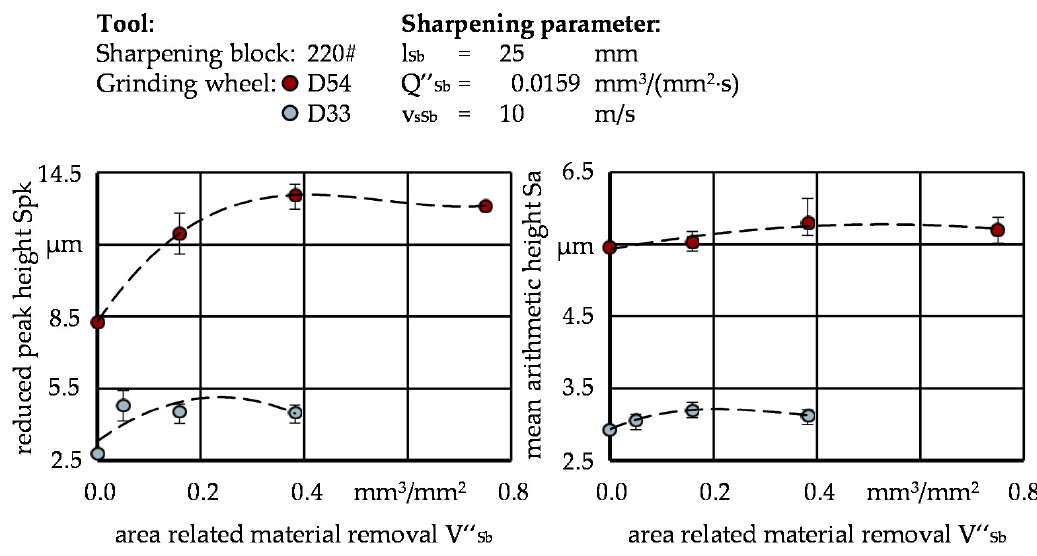
Figure 6. Influence of the area-related material removal in sharpening V’’ Sb.